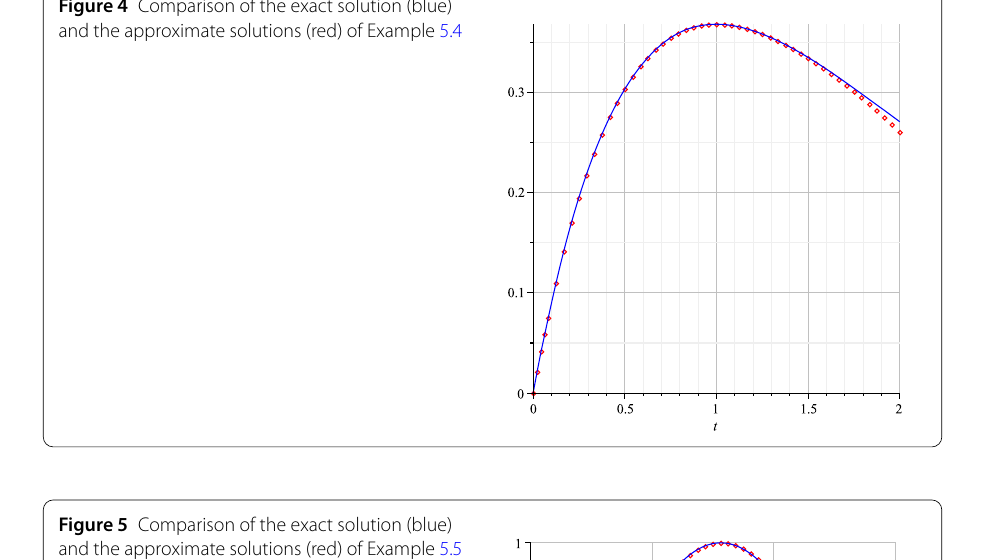
Figure 4 Comparison of the exact solution (blue) and the approximate solutions (red) of Example 5.4